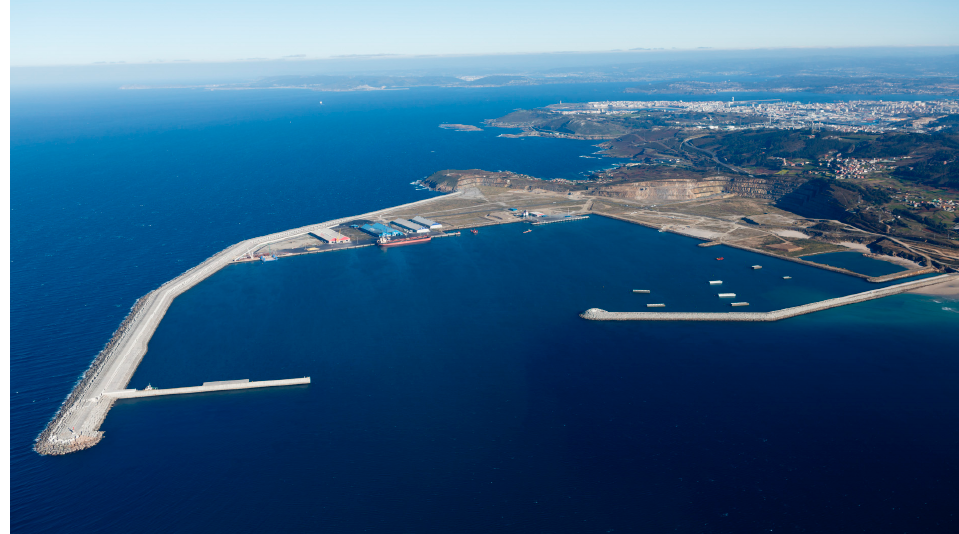
Figure 1. Aerial view of the outer port of Punta Langosteira, A Coruña, Spain.